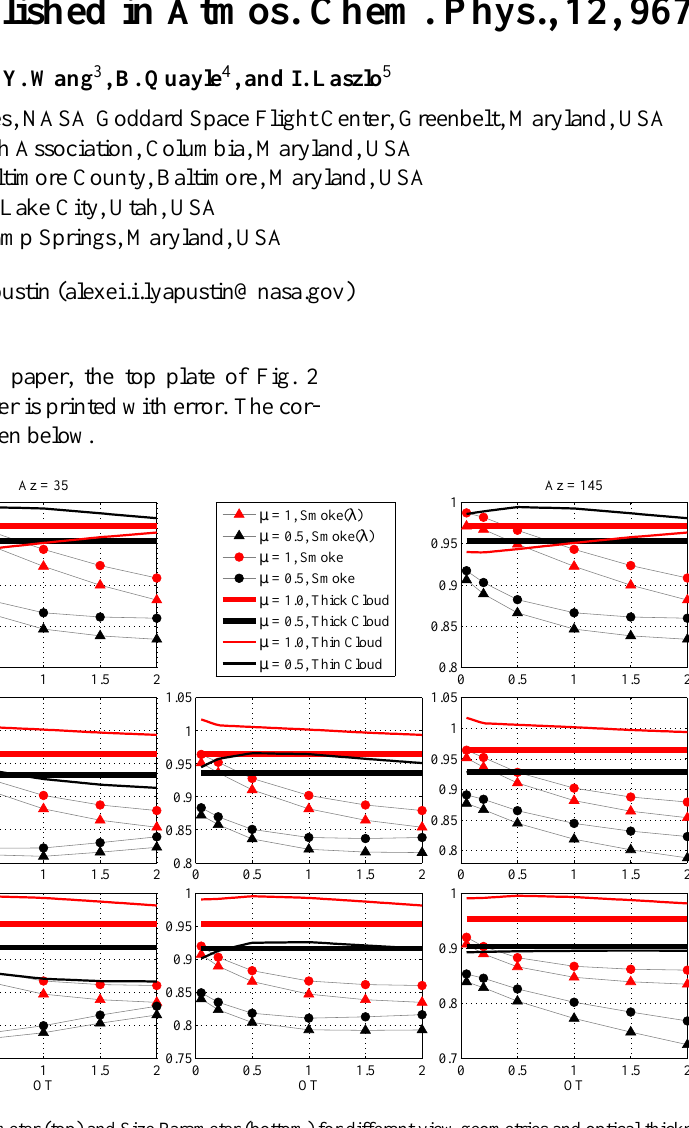
Fig. 2. Simulated Absorption Parameter (top) and Size Parameter (bottom) for different view geometries and optical thickness (OT) for absorbing aerosols (symbols) and clouds (lines). The rows show different solar zenith angles (SZA=0, 45, 60 ◦ ), and columns show different relative azimuths ( ϕ =35, 90, 145 ◦ ). The red and black color represents different view zenith angles ( µ =1 and 0.5, respectively). The thick and thin lines show results for thick and thin (with given OT) clouds, respectively. The circles and triangles indicate aerosols with AAE ∼ 2 (Aerosol ( λ )) and spectrally independent imaginary refractive index (Aerosol), respectively. The parameters of simulations are provided in the